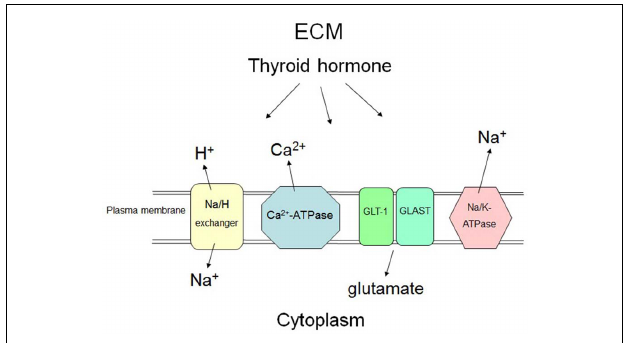
FIGURE 1 | Selected mechanisms at the plasma membrane by which thyroid hormone may non-genomically or genomically have protective effects on neurons and glial cells in the setting of acute brain ischemia. In response to thyroid hormone (T 3 ), astrocytes and neurons may take up glutamate from the extracellular apace via increased activity of specific transporters (GLAST and GLT-1), reducing neuroexcitation fostered by glutamate at the neuronal surface.The hormone may also increase the number of glutamate transporters in the plasma membrane.Thyroid hormone (T 3 ) increases activity of the Na/H exchanger, reducing the intracellular acid load that results from ischemia. Sodium pump (Na, K-ATPase) activity is enhanced byT 3 and there is increased expression of the Na, K-ATPase gene in response to iodothyronines. Export of Na + by the pump is relevant because of the increased activity of the Na/H exchanger results in import of Na + . An increase in [Na + ] i.c. results in an undesirable increase in cell uptake of Ca 2 + by sodium–calcium exchange (not shown in the figure). Enhanced activity of the calcium pump (Ca 2 + -ATPase) caused by thyroid hormone (T 4 andT 3 ) also protects against intracellular accumulation of Ca 2 + . ECM, extracellular